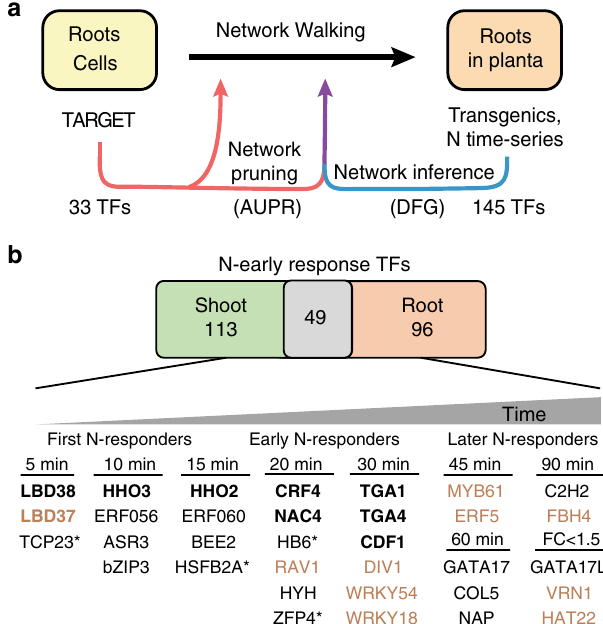
Fig. 1 Network Walking connects validated direct transcription factor (TF) targets to in planta responses. a Schematic overview: the Network Walking approach charts a network path from direct targets of a TF identi fi ed in cells to its indirect targets, which only respond in planta. This is achieved using data for 33 TF perturbations in root cells using TARGET (Transient Assay Reporting Genome-wide Effects of Transcription factors) 18 scaled-up in this study, and a time-series transcriptome of nitrogen (N) response in whole roots 29 . TF – target edges for 145 TFs were inferred using this time-series data in a machine-learning method called dynamic factor graphs (DFG) 48 (blue arrow). The inferred edges were pruned for high-con fi dence edges (purple arrow) using 71,836 validated edges (red arrow) for 33 TFs in a precision/recall analysis (area under precision recall (AUPR)). The validated edges and high-con fi dence inferred edges are used to link a TF to its indirect targets in planta via the Network Walk. b The 33 TFs were selected based on their response to N in shoots and roots (black TFs) or roots only (orange TFs) from the N-treatment time-series data of